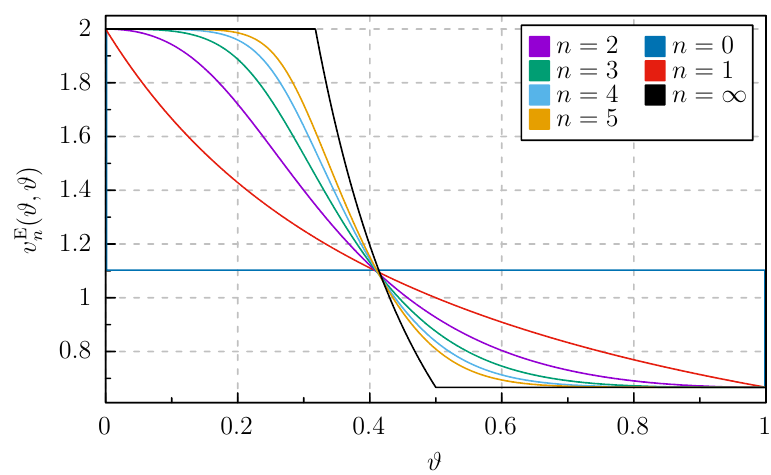
Figure 3: Entanglement velocity (cf. (69)) as a function of the filling ϑ (note that